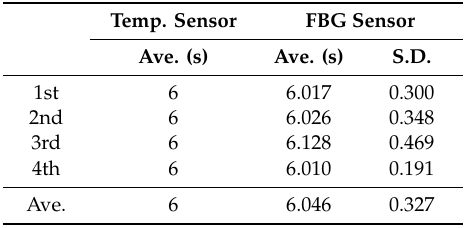
Table 1. Average one-cycle respiratory time measured by the FBG sensor.